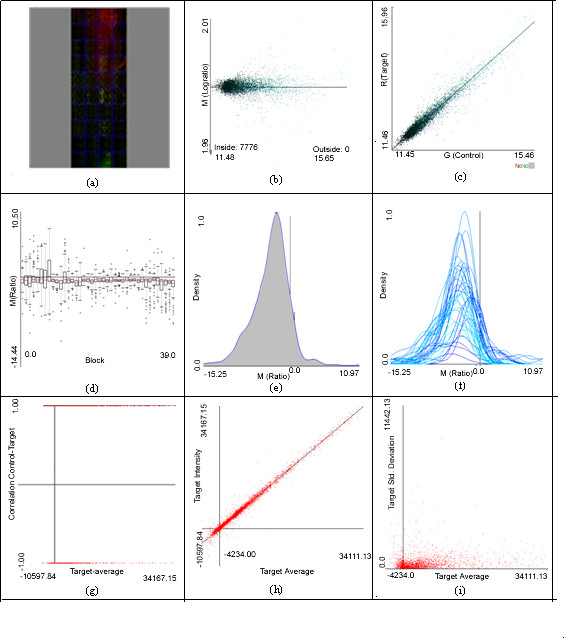
Some PreP+07 views. a) slide view, (slide view of coherent data, slide view with quality also available) b) MA plot, c) RG plot, d) box graph, e) density distribution of ratios, f) density distribution of ratios within each sector, g) correlation of replicated spots vs. their average h) normality of replications i) deviation of replicated spots vs. their average.